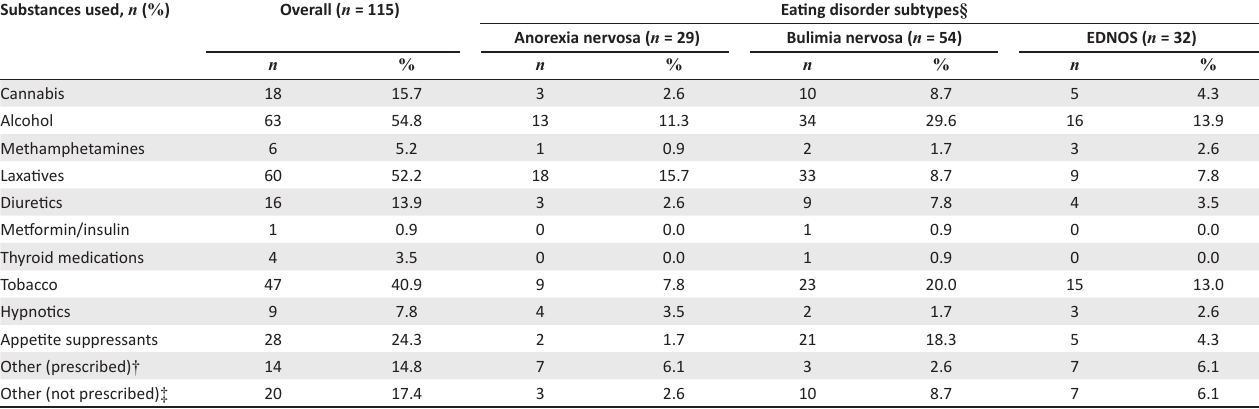
TABLE 2: Profile of substances used by participants with different eating disorder subtypes ( n = 115). Substances used, n ( % ) Overall ( n = 115)